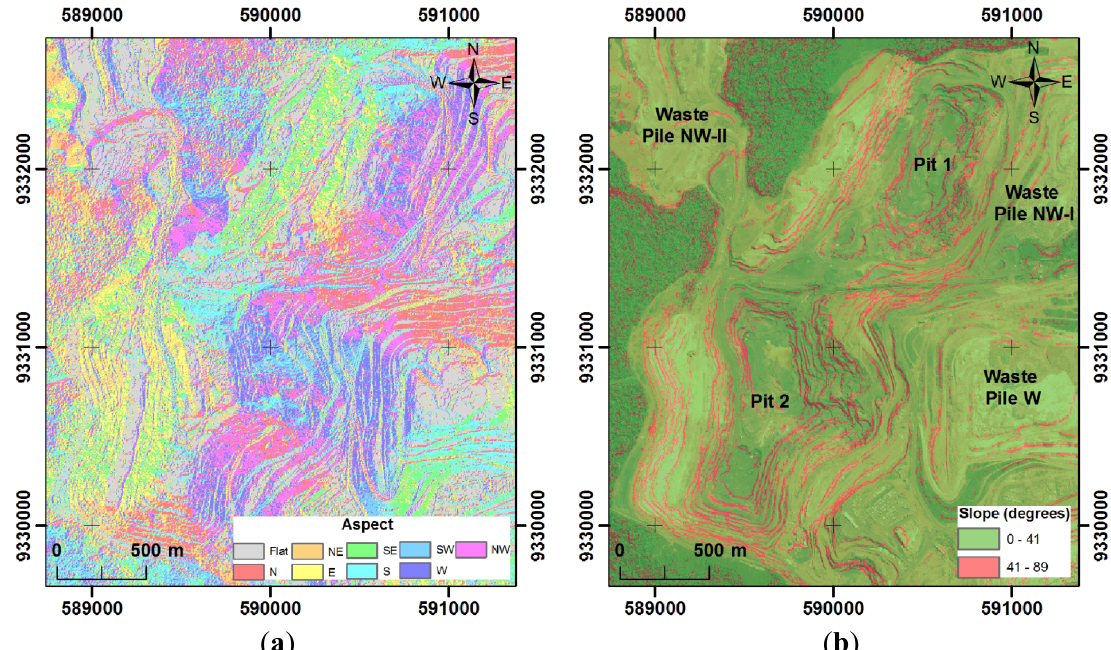
Figure 4. ( a ) Aspect map (azimuth) and ( b ) Slope map superimposed on a GeoEye-1 colored